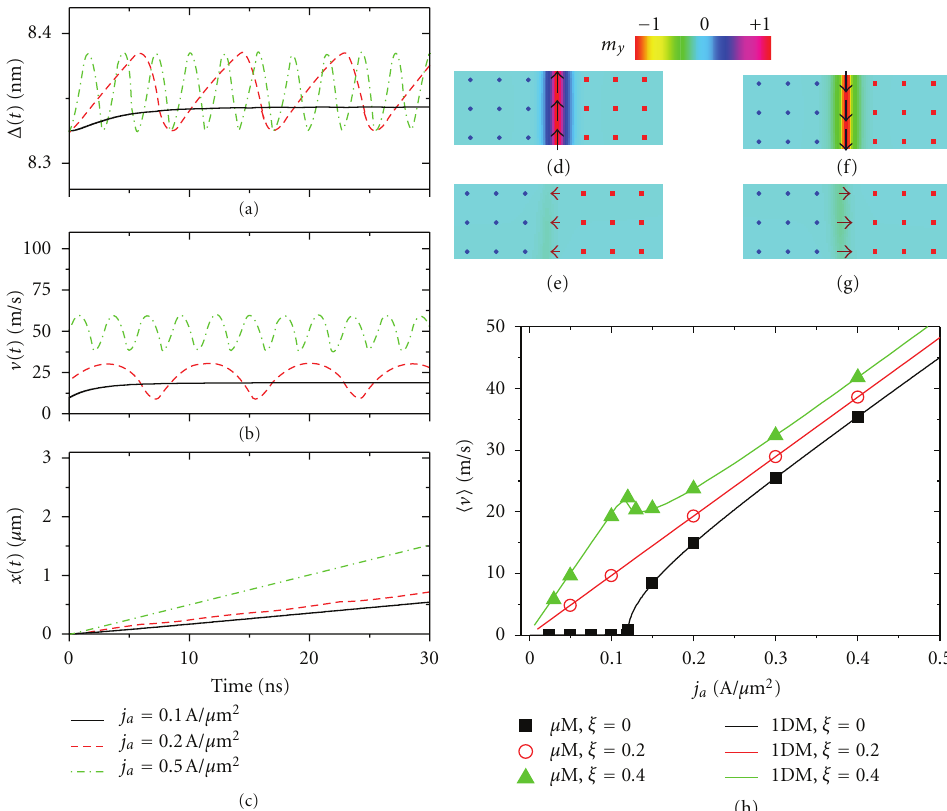
Figure 2: Current driven DW dynamics along a perfect strip with L y × L z = 120 × 3nm 2 . (a), (b), and (c) depict the micromagnetically ( μM ) computed temporal evolution of the DW width Δ , the DW velocity v , and the DW position x under three di ff erent density currents: j a = 0 . 1A /μ m 2 , j a = 0 . 2 A/ μ m 2 , and j a = 0 . 5A/ μ m 2 for a nonadiabatic parameter of ξ = 0 . 4. (d)–(g) show typical micromagnetic states of the propagating DW for currents larger than the Walker breakdown ( j a > j W ( ξ )). (h) Time-averaged DW velocity as function of j a for three di ff erent values of the nonadiabatic parameter: ξ = 0, ξ = 0 . 2 and ξ = 0 . 4. Dots correspond to μM results, whereas lines are predictions from the 1DM with Δ = 8 . 325nm and H K = 12533 . 5 A/m. (Reprinted with permission From [70, 72]. Copyright (2012), American Institute of